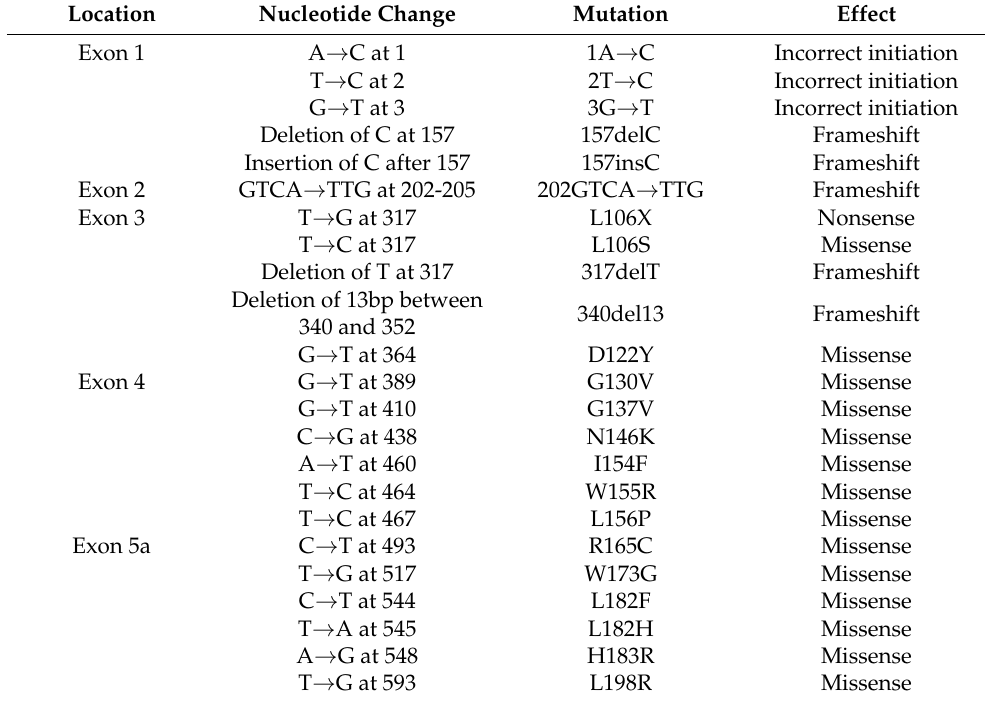
Table 1. List of deletions, insertions and substitutions in the coding sections of the frataxin gene responsible for the FRDA known, to date (more comprehensive tables can be found in Pook, 2000 [102] and Gellera, 2007 [99]).